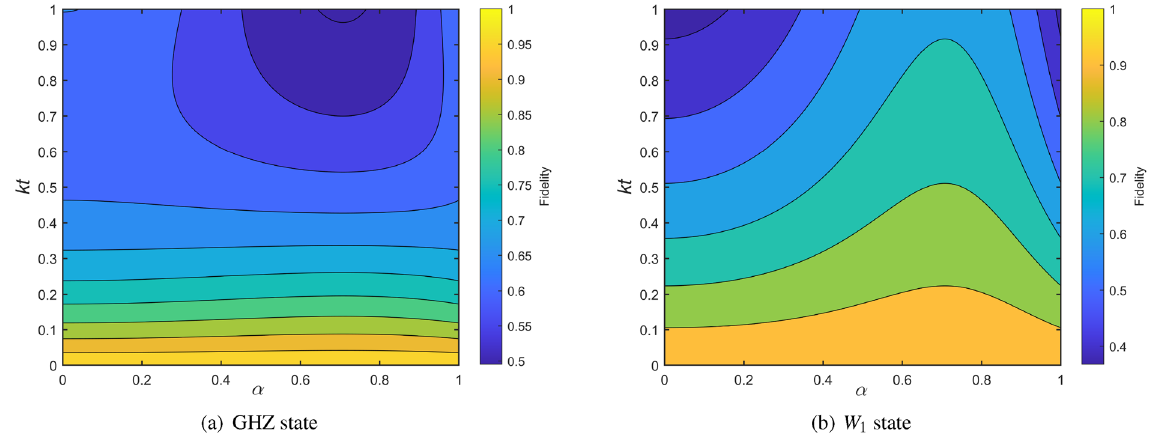
Figure 1. The fidelities of quantum teleportation using GHZ and W 1 state under amplitude damping noise is described by a master equation in the Lindblad